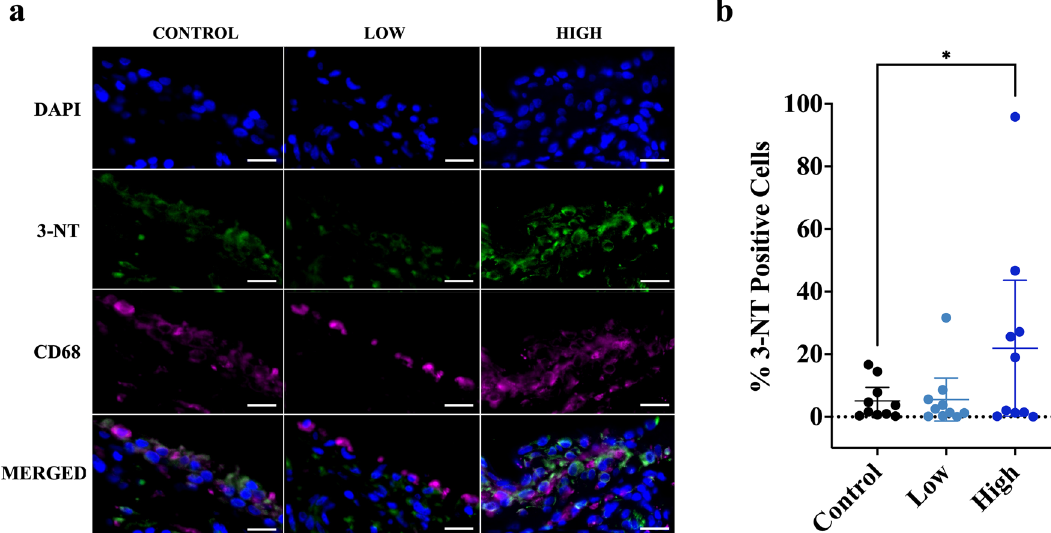
Figure 3. Cyclic tensile strain increases 3-NT staining in OA synovial tissue. ( a ) Representative immunofluorescence images of 3-NT (green) and CD68 (magenta) for each cyclic tensile strain loading condition. ( b ) Dot plots displaying the individual 3-NT + cells (mean ± 95% CI) for Control (black), Low (light blue), and High (dark blue) tensile strain conditions. Scale bar = 20 μm. 3-NT, 3-Nitrotyrosine; CD68, macrophage marker; CI, confidence interval; DAPI, nuclear